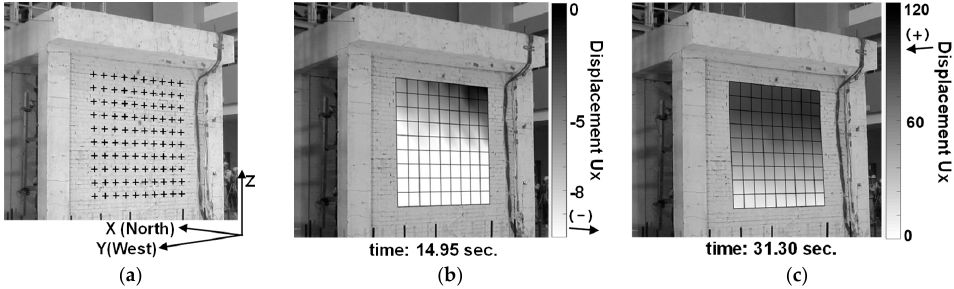
Figure 25. Wall torsion and bending observed from image analysis data. Image measurement quantifies structural dynamic responses that is difficult to acquire by local sensors in the experiment. ( a ) Mesh of tracked points. ( b ) Analyzed wall torsion ( c ) Analyzed wall